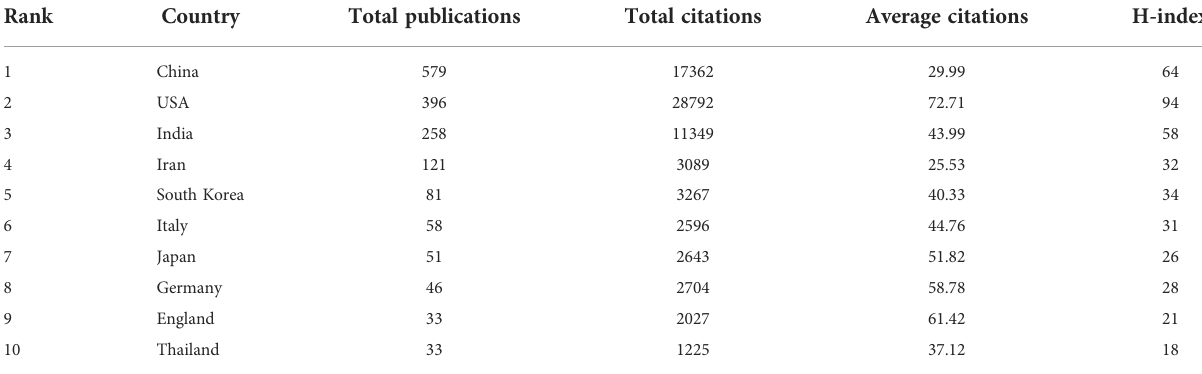
TABLE 1 The top 10 countries that contributed publications on the curcumin.